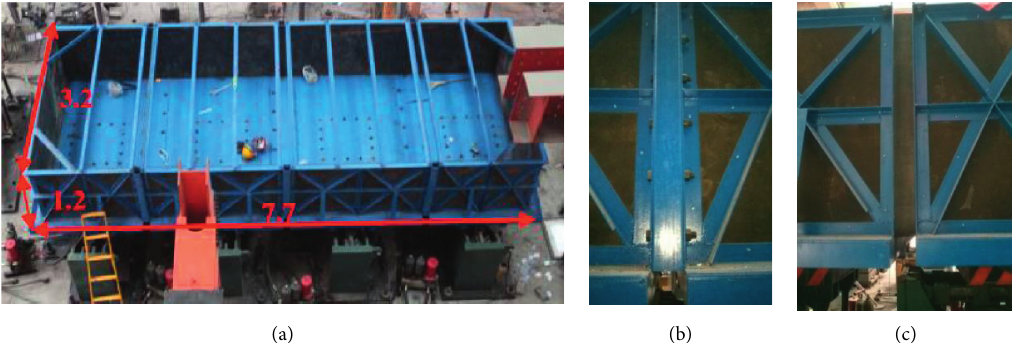
Figure 6: Soil box (a) Layout; (b) Two box connections during uniform seismic excitation; (c) Two boxes separate from nonuniform seismic excitation.